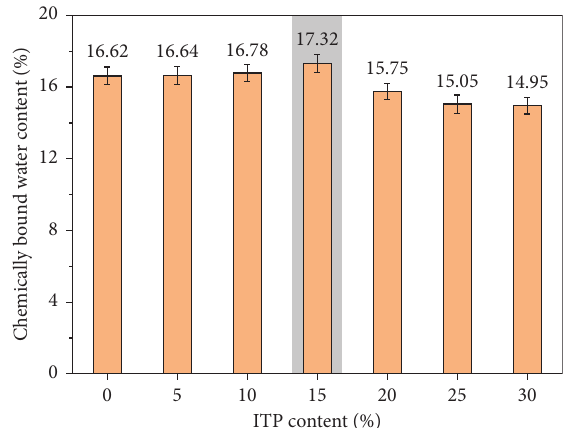
Figure 3: The bound water content of samples containing different contents of